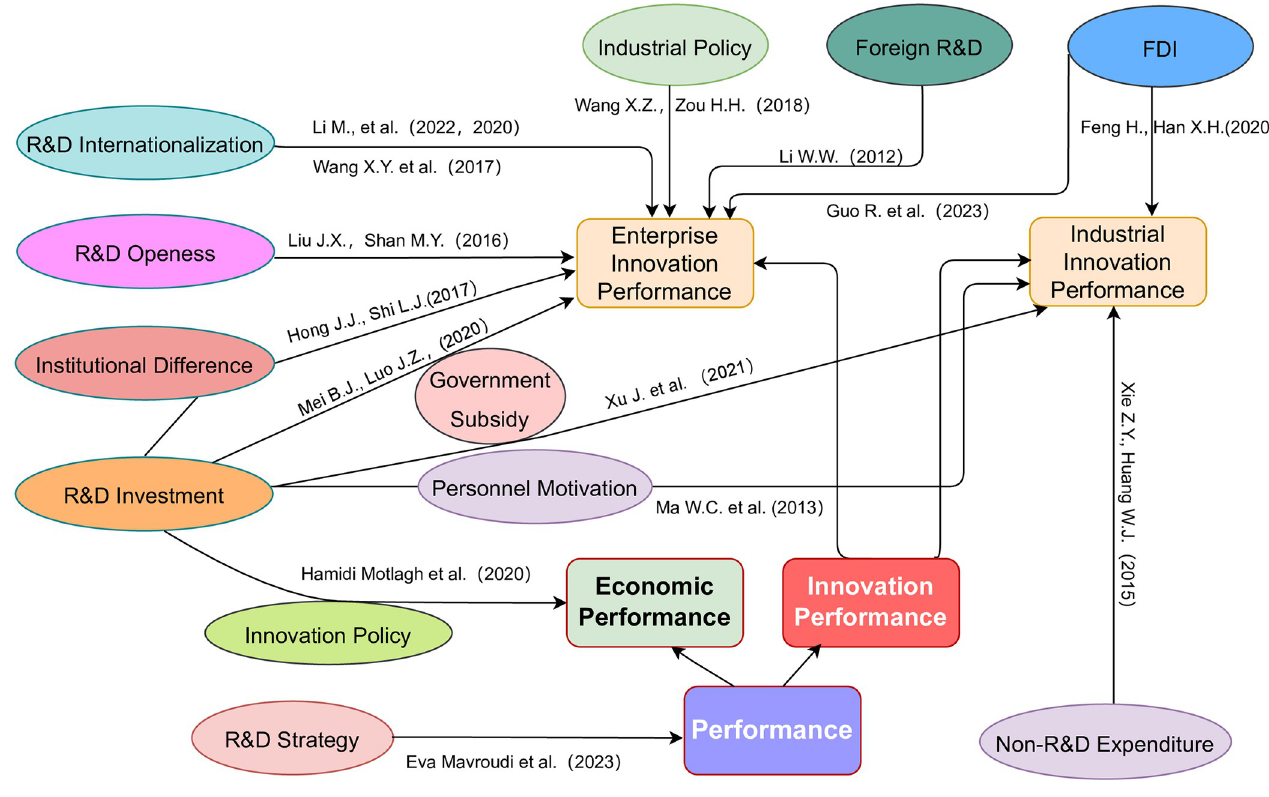
Fig 1. Literature collation of R&D input and